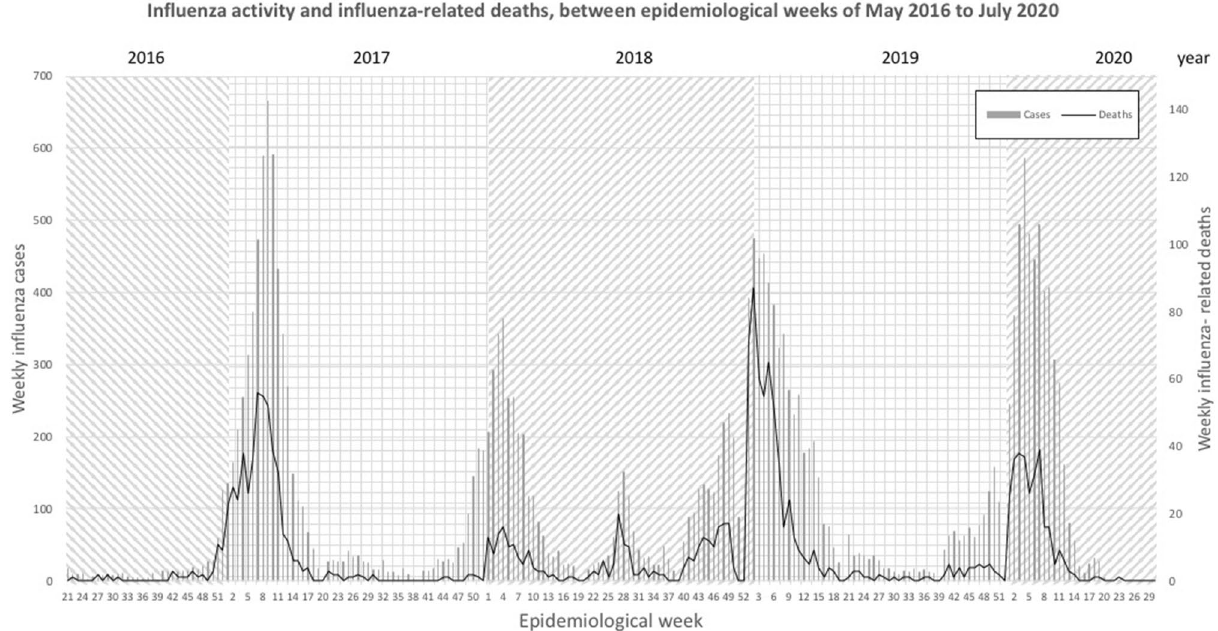
Figure 1. Trends of influenza activity and influenza-related deaths during the 2019–2020 season compared with average of the preceding 3 years (between EPI weeks of May 2016 to July